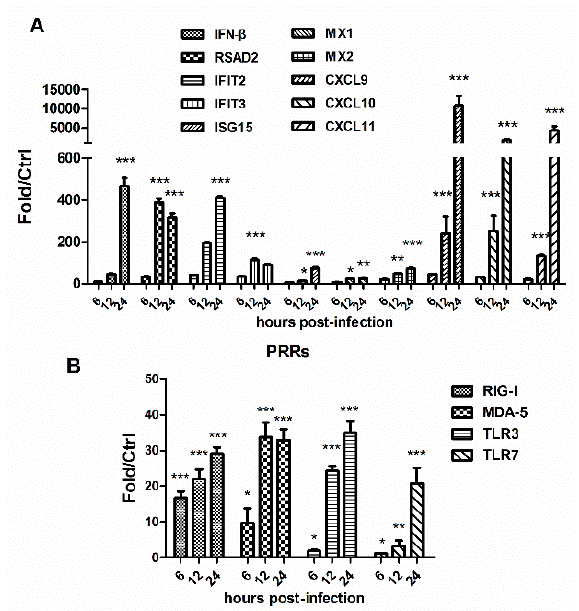
Figure 6. Changes of genes associated with IFN pathway in response to virus infection by qRT-PCR analyses. ( A ) A set of antiviral genes and ISGs were tested; ( B ) PRRs change in response to virus infection. GAPDH was used for normalization. Data was mean ± SEM of triplicate reactions for each gene. Fold change was calculated using the comparative Ct method. Statistical significance of the control infection was analyzed by student’s t -test.